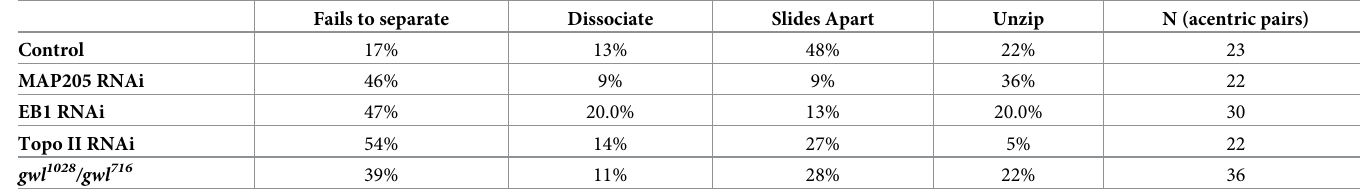
Table 3. Acentric separation occurs through three distinct modes. Acentric sister chromatids either fail to separate or separate from one another by three different modes: laterally sliding past one another, unzipping from one another, or simultaneously and evenly dissociating along their lengths. Fails to separate